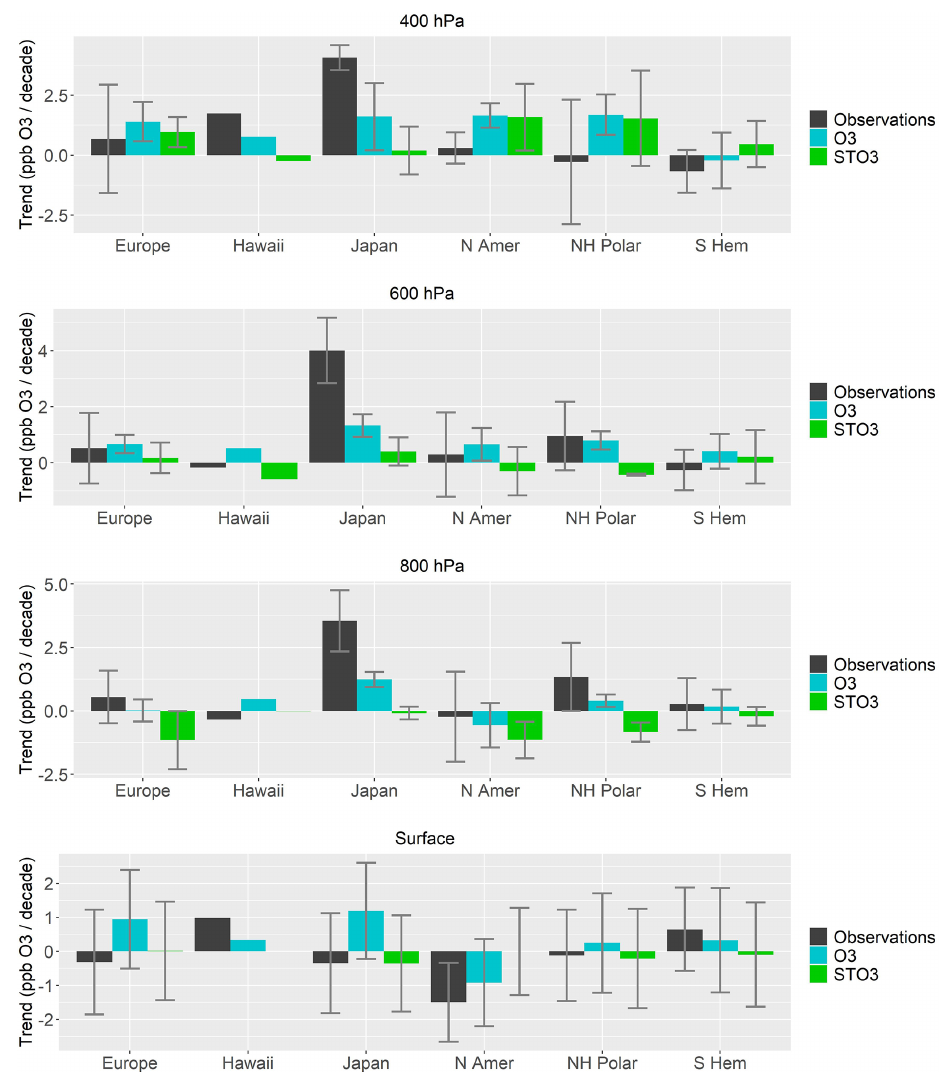
Figure 12. Trends in tropospheric ozone in observations and in MERRA2-GMI at four pressure levels (surface, 800, 600, and 400hPa) from 1990–2017, averaged over six regions. Observed ozone trends at ozonesonde and surface sites (black bars) are compared with MERRA2- GMI ozone (blue bars) and with STO3 (green bars), a tracer of the influence of stratospheric ozone in the troposphere (green bars). Thin gray bars denote the standard deviation across